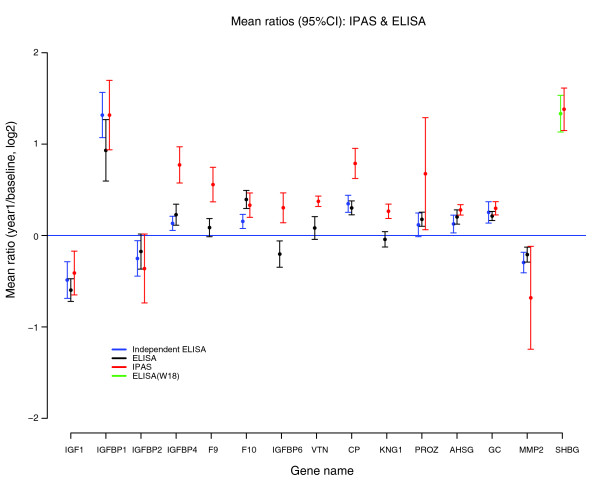
Mean ratios (95% confidence intervals (CI)) for MS-based (IPAS, shown in red) and ELISA-based quantification (shown in black for the same set of 50 sera analyzed by MS and in blue for the independent set of 50 sera). SHBG ELISA data were based on a separate independent set of sera.